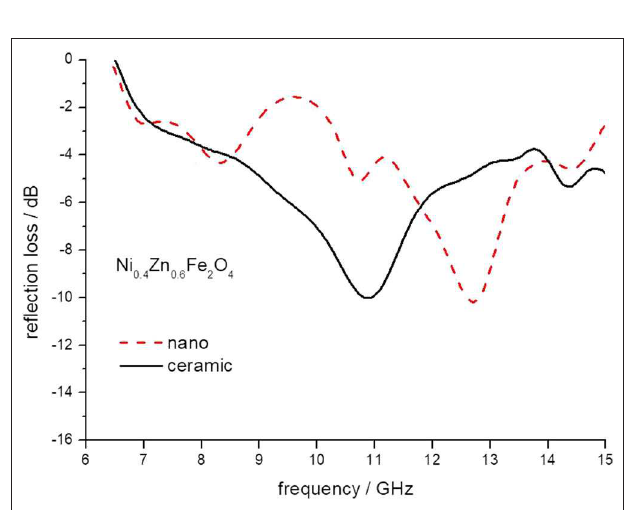
FIGURE 7 | The reflection loss of epoxy composite containing ceramic and nanoparticles of Ni 0.4 Zn 0.6 Fe 2 O 4 ferrites.